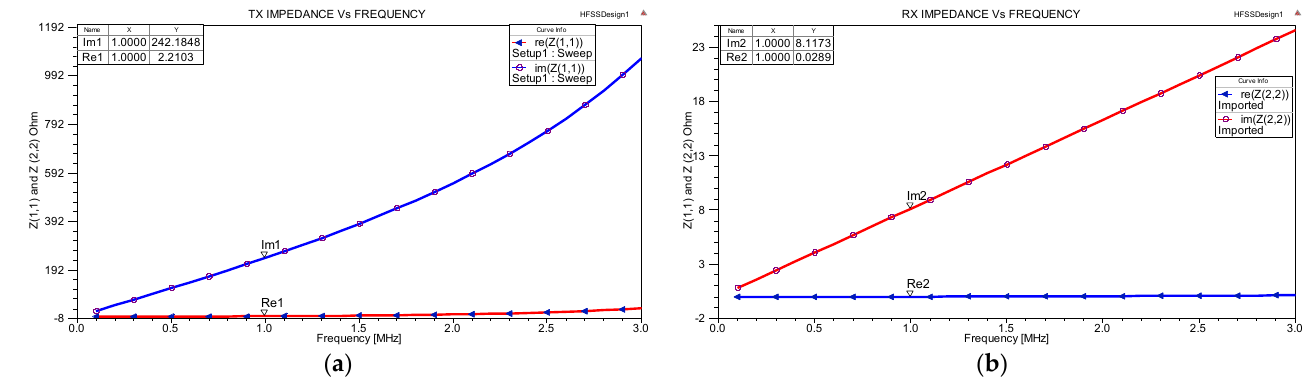
Figure 11. The Im and Re of lumped circuit and performance parameters of vertical alignment at 1 MHz frequency and with a distance equal to 2 cm of Z-impedance: ( a ) Transmitter coil (Tx); and ( b ) receiver coil (Rx). Figures 12a–c show the Q 1 , Q 2 , and L s , L r , M , and k of the transmitter and receiver coils versus frequency at the maximum transfer distance of 50 cm. Figure 12a, shows the Q 2 (m1: in blue) start to increase when the frequency is equal to 0.125 MHz and the start range decreases from 0.25 to 1.5 MHz because of the proximity to the 2 cm air gap, and the differences in the design of the coils such as the values of N T , d out , and d in between transmitter and receiver coils. Therefore, the Q 1 (m2: in red) increased slightly from 0.3 to 0.7 MHz before it dropped again. In addition, Figure 12a shows the L S , L r (pink and green lines, respectively) values of the transmitter and receiver coils.